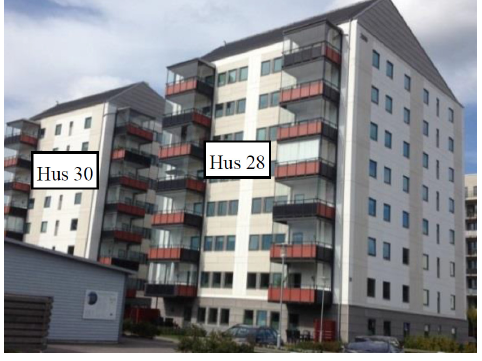
Figure 1. Two wood-framed passive houses in Portvakten